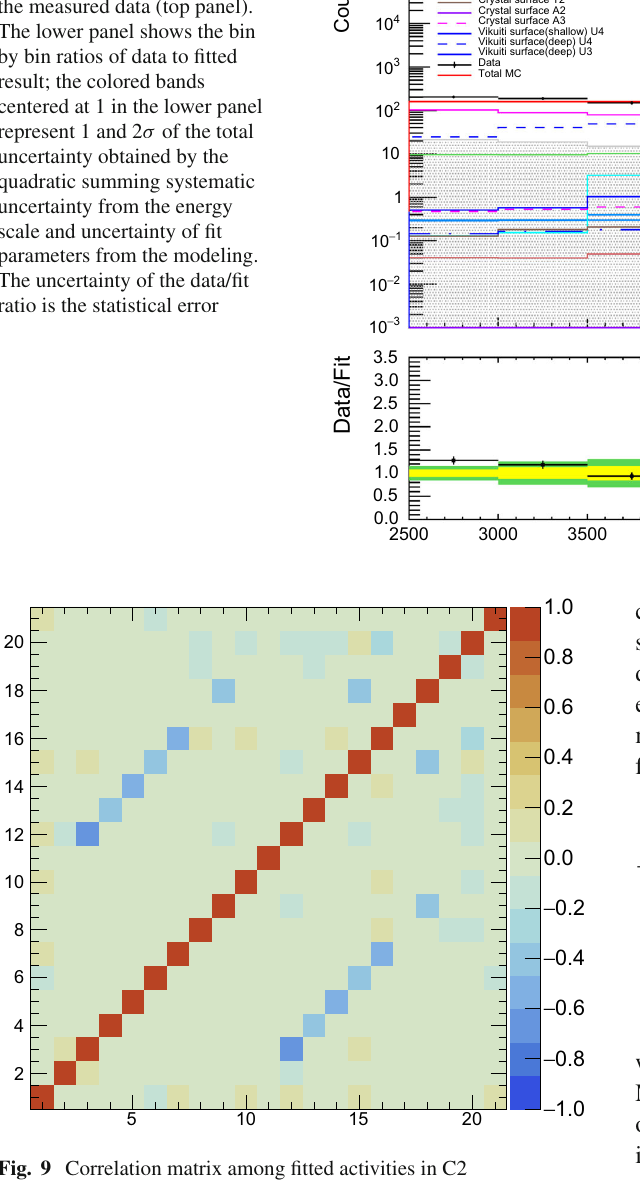
1 µ m. Thus, we used both shallow and deep depth surface simulations for 210 Pb on Vikuiti surfaces in the α background